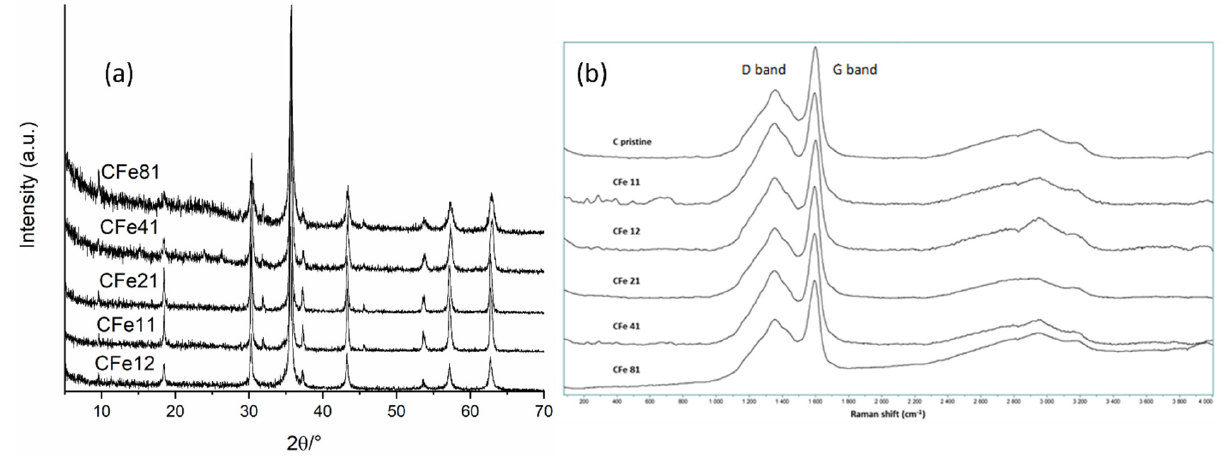
Figure 5. ( a ) XRD patterns and ( b ) Raman spectra of all samples.